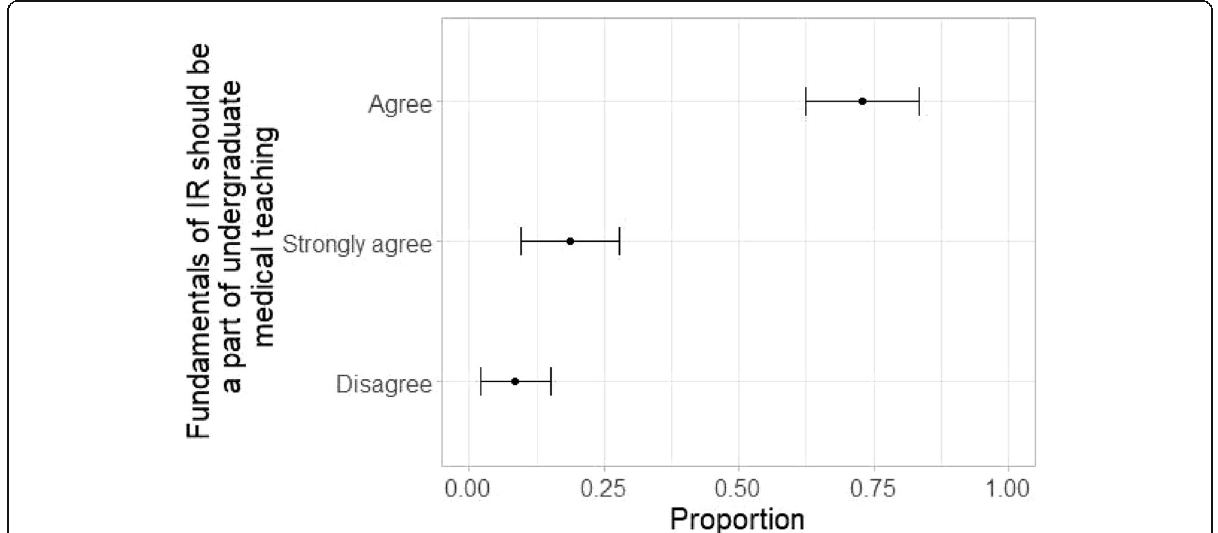
Fig. 5 N = 70. Responses to survey question ‘ Do you agree that basics of IR should be a part of medical undergraduate teaching? ’ . Majority of